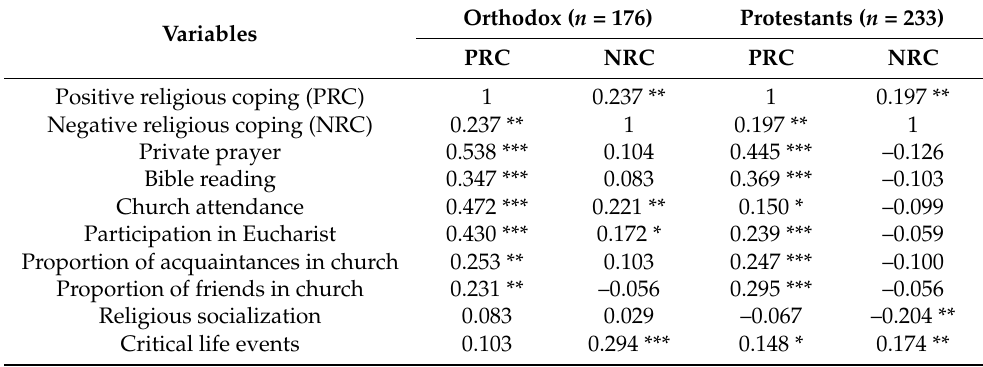
Table 9. Correlation between Brief RCOPE subscales and the variables included in the study.